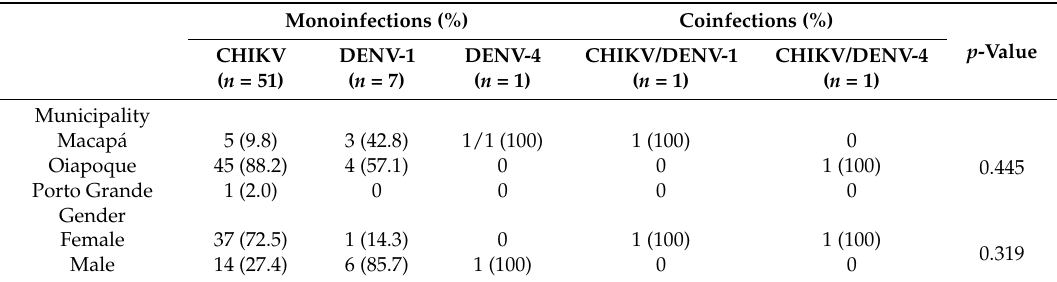
Table 2. Clinical, epidemiological, and demographic distribution of CHIKV and dengue virus (DENV) monoinfections and coinfections in Amap á State in 2014 and